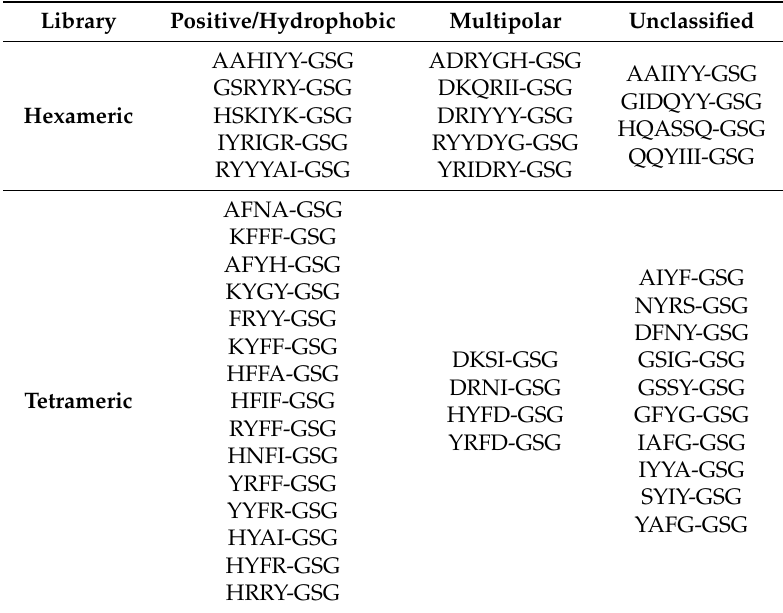
Table 1. Lead HCP-binding peptide candidates. The sequences specified here were determined via comparison of LC/MS/MS spectra to a FASTA sequence library of all possible peptide sequences in the combinatorial library from the combinatorial library beads that were identified as HCP-positive and IgG-negative solid phase fluorescent screening